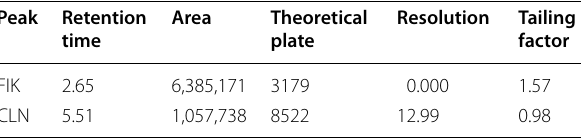
Table 2 System suitability